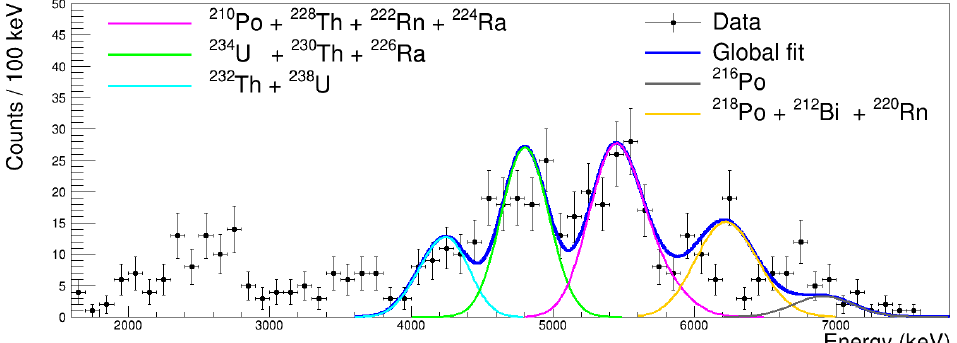
Figure 6. α energy spectrum picked out using the PSD from the data accumulated with the CHC crystal scintillator over 2848 h. The fit model built from α decays of 238 U and 232 Th with daugh- ters is highlighted by blue solid line, and some individual fit contributions are also presented. The energy scale is in α energy having considered the Q.F. studied in Ref. [27] (taken from Ref. [27] with